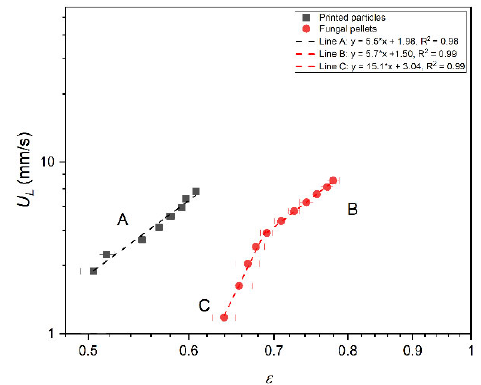
Figure 11. R–Z relationships based on bed expansion characteristics for 3D ‐ printed particles and fungal